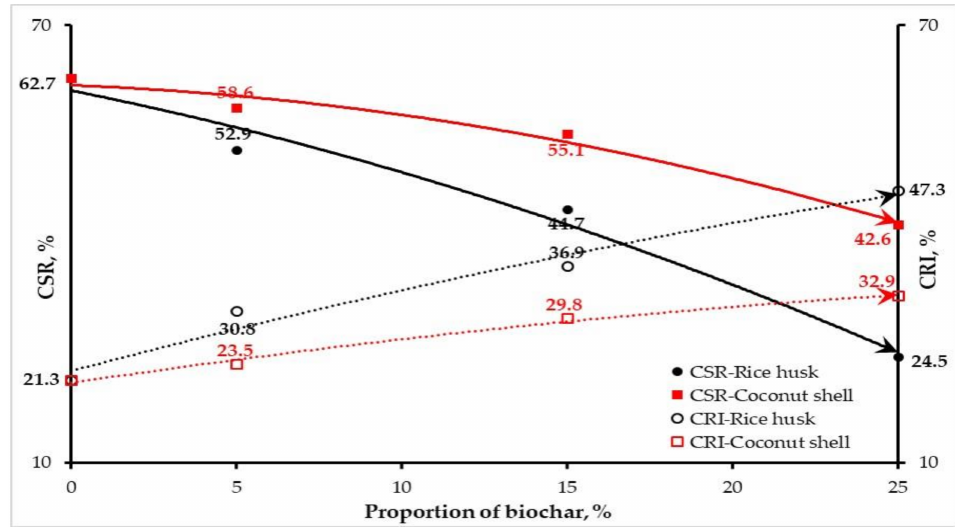
Figure 8. CSR and CRI of coking blends containing various amounts of biochar.